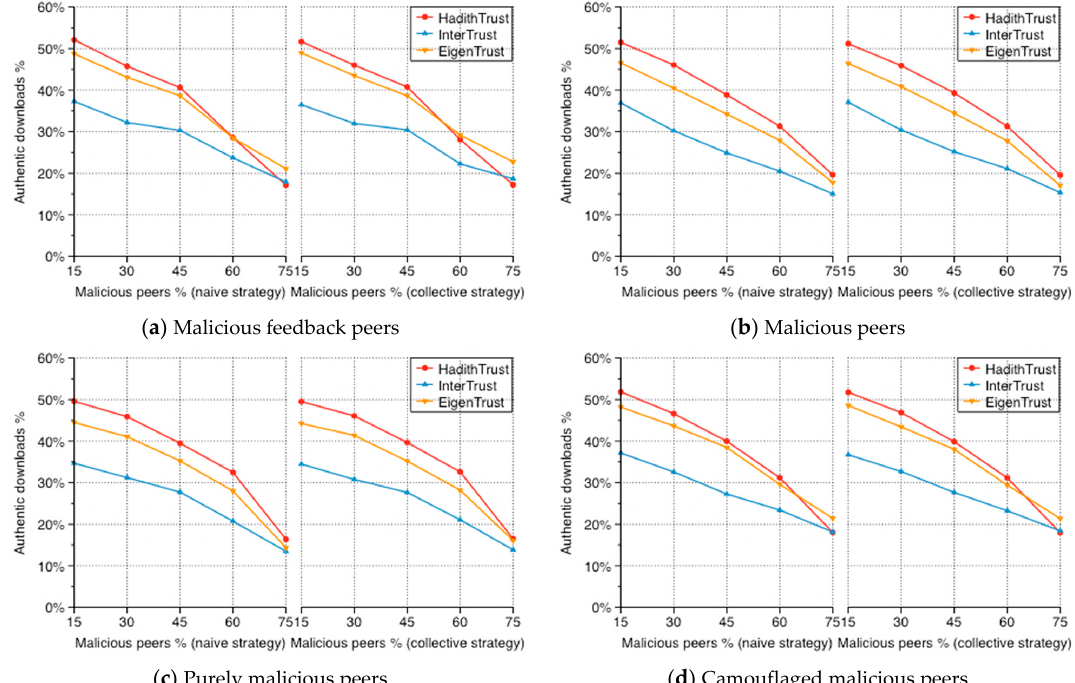
Figure 13. Percentage of authentic downloads.